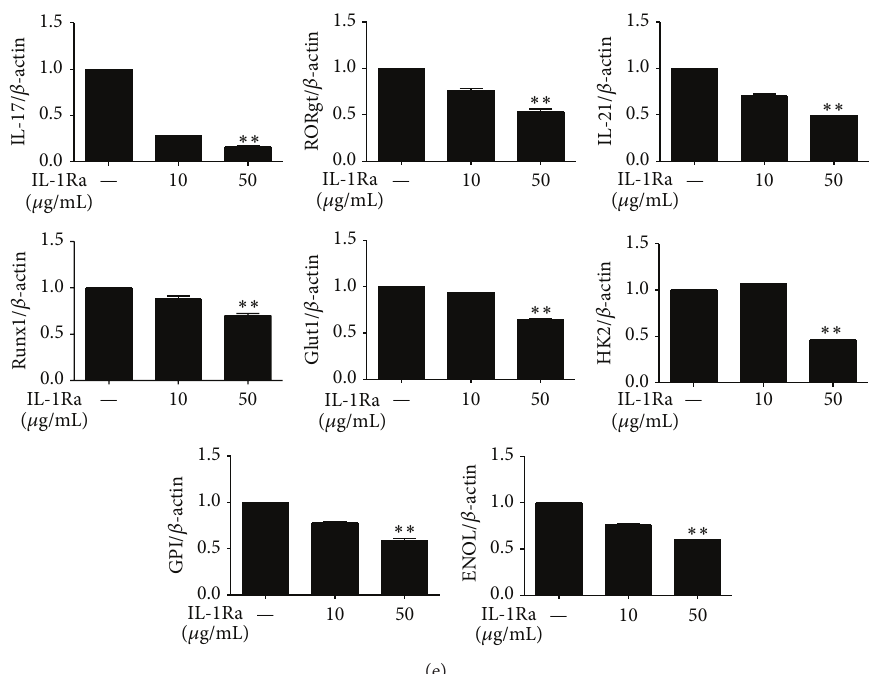
Figure1:IL-1 𝛽 controlstheglycolysispathwayanddifferentiationintoThelper(Th)17cells.SplenocytesfromC57BL/6micewereactivatedin theTh0conditioninthepresenceorabsenceofeitherIL-1receptorantagonist(IL-1Ra)orrecombinantIL-1 𝛽 for3days.(a)Theconcentrations of interferon- (IFN-) 𝛾 , IL-4, and IL-17 in culture supernatants were measured by means of enzyme-linked immunosorbent assays (ELISAs). ((b) and (c)) The mRNA levels of IL-17, ROR 𝛾 t, and glycolysis-related factors were quantified using real-time PCR. Splenocytes from C57BL/6 mice were cultured under Th17-polarizing conditions for 3 days in the presence or absence of IL-1Ra. (d) The proportion of CD4 + IL-17 + cells or CD4 + CD25 + Foxp3 + cells was determined using intracellular flow cytometric analysis. (e) The mRNA expression of IL-17, IL-21, Runx1, ROR 𝛾 t, Glut1, HK2, GPI, and MNOL was quantified using real-time PCR. ∗ 𝑃 < 0.05 , ∗∗ 𝑃 < 0.01 , and ∗∗∗ 𝑃 < 0.001 . Data are representative of 2 independent